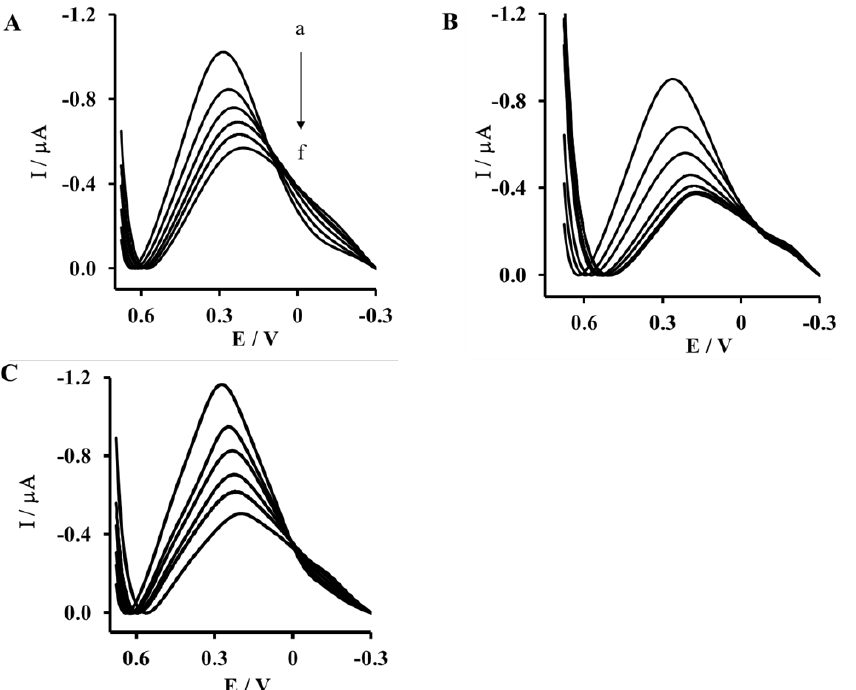
Figure 3. The representative Osteryoung Square Wave Voltammetry (OSWV) responses measured with electrodes: ( A ) Au-NAC/DPTA–Cu(II)–His in TRIS buffer in the presence of Ca 2+ ; ( B ) Au-NAC/DPTA–Cu(II)–His natural domain in diluted human plasma in the presence of Ca 2+ and ( C ) Au-NAC/ DPTA–Cu(II)–His –RAGE VC1 natural domain in TRIS buffer with 10 nM Aβ 6 presence of Ca 2+ towards S100B protein in the presence of 50 mM TRIS-HCl, pH 7.4.